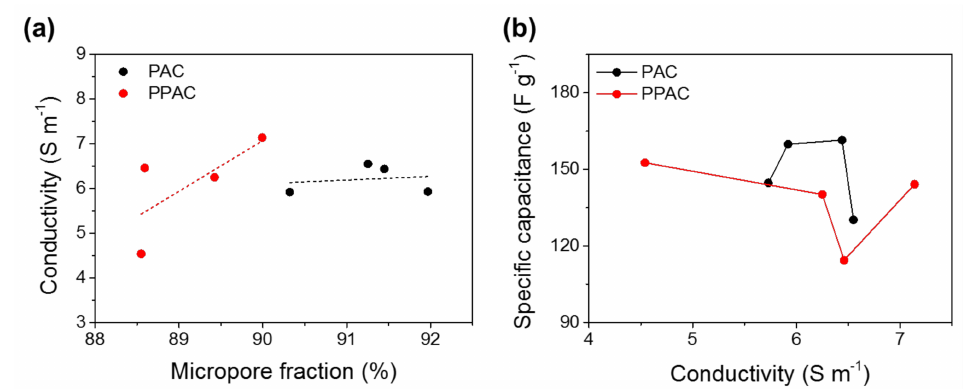
Figure 5. ( a ) Relationship between the electrical conductivity and micropore fraction of activated carbons with different BET surface areas. ( b ) Relationship between the specific capacitance and micropore fraction of activated carbons with different electrical conductivities.